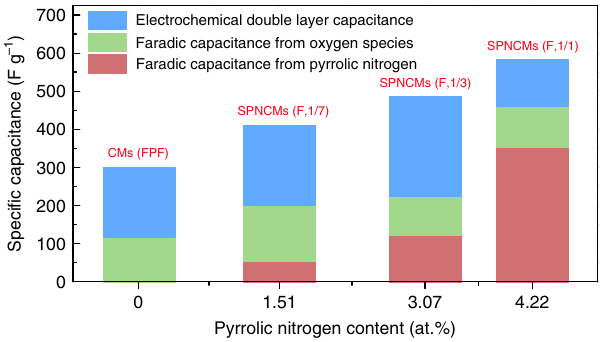
Fig. 7 Variations in the capacitances for the samples. Variations in the pseudocapacitances with respect to pyrrolic nitrogen content in CMs (FPF), SPNCMs (F, 1/7), SPNCMs (F, 1/3), and SPNCMs